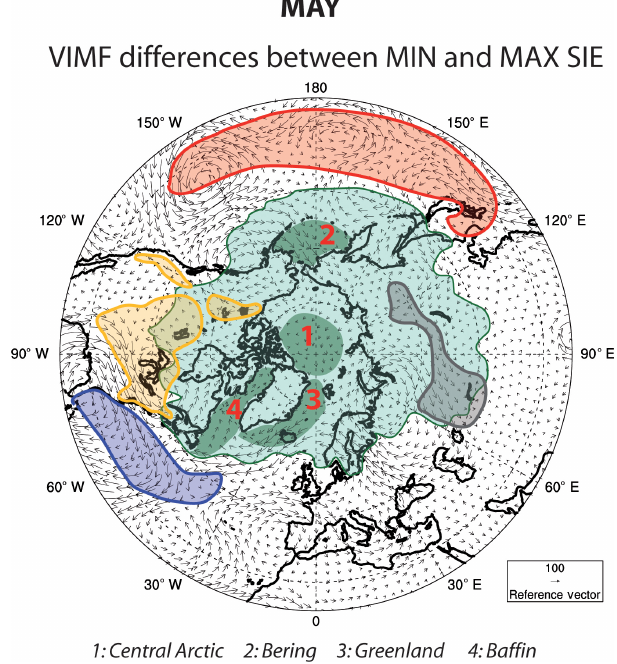
Figure 5. Composite of differences of vertical integrated moisture flux (VIMF) (vector, kgm − 1 s − 1 ) between low- and high-SIE years for May. The AR (light green filled region), the Pacific, Atlantic, North America, and Siberia moisture sources (red, purple, yellow, and grey filled areas, respectively) and the main AO subregions cen- tral Arctic (1), Bering (2), Greenland (3), and Baffin (4) are also